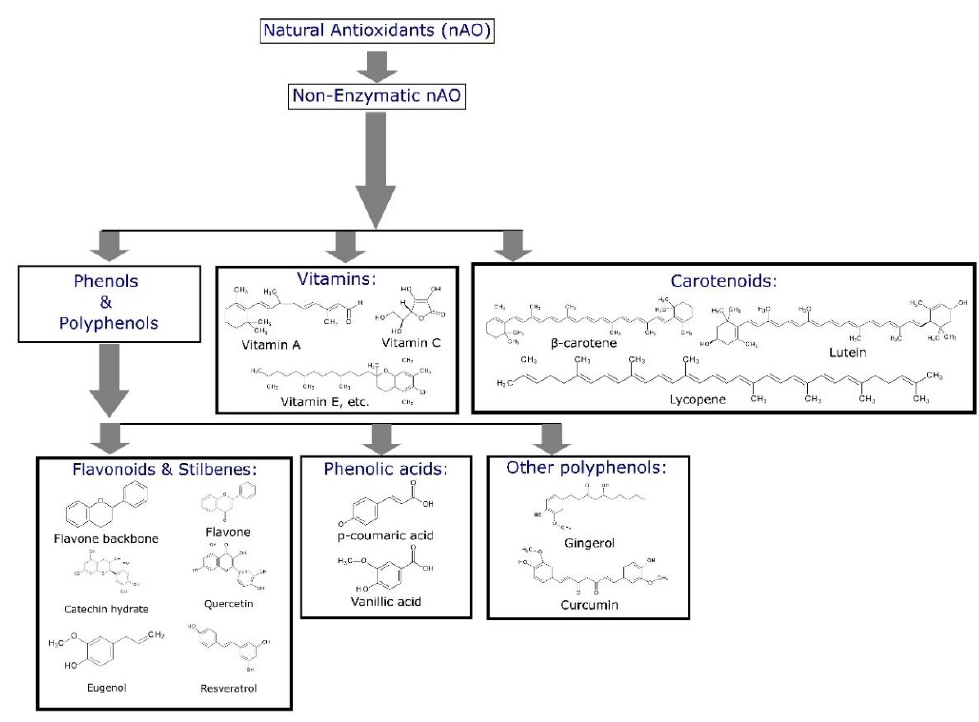
Figure 1. Classification and basic chemical structures of antioxidants applied in polymers